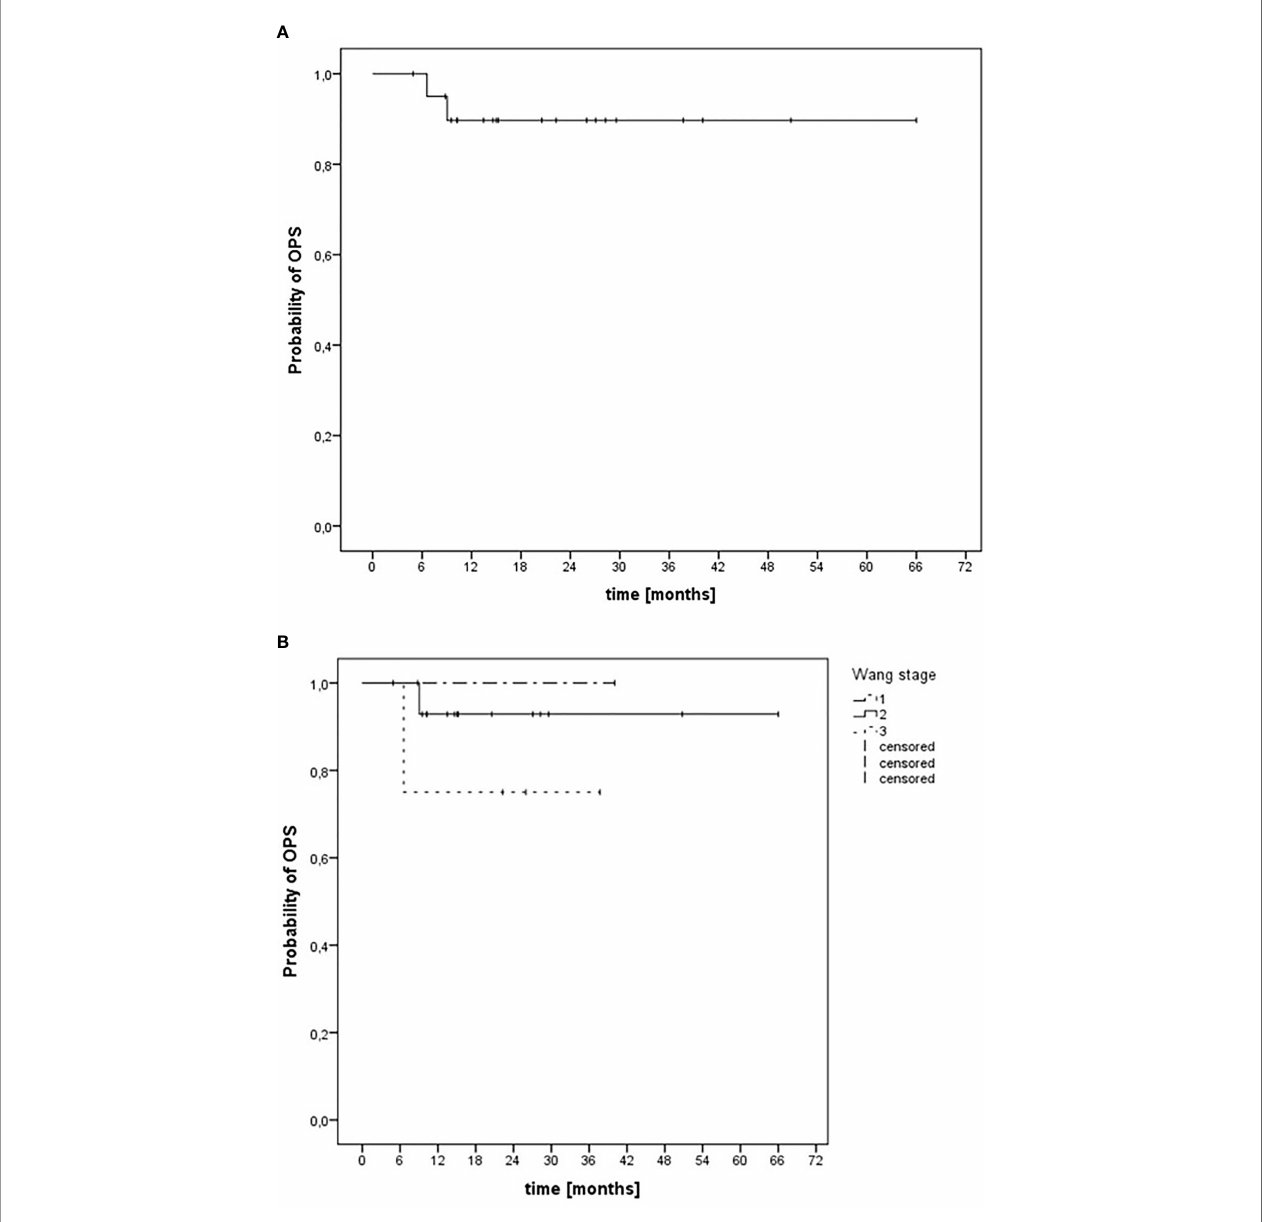
FIGURE 3 | Kaplan – Meier estimation of organ-preserving survival (OPS) after CIRT-B combined with VMAT. (A) OPS independent of tumor stage. (B) OPS depending on Wang